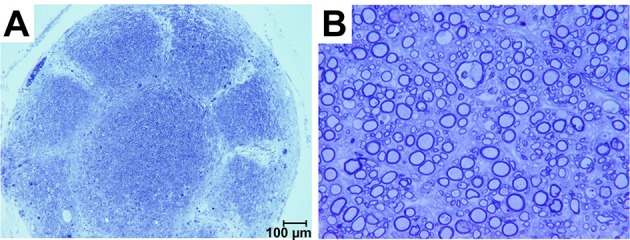
Photomicrographs of toluidine blue stained axons regenerated in a macro-sieve electrode without GDNF. (A) Low magnification of a cross-section sliced 300 μm proximal to macro-sieve interface. (B) High magnification image shows both myelinated and unmyelinated regenerated axons.